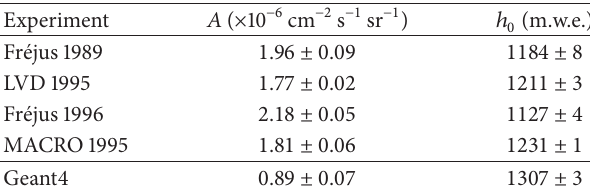
Figure 3: Integrated intensity of muons as a function of depth (color online). Table 1: Fit parameters from intensity-depth relation in (3).